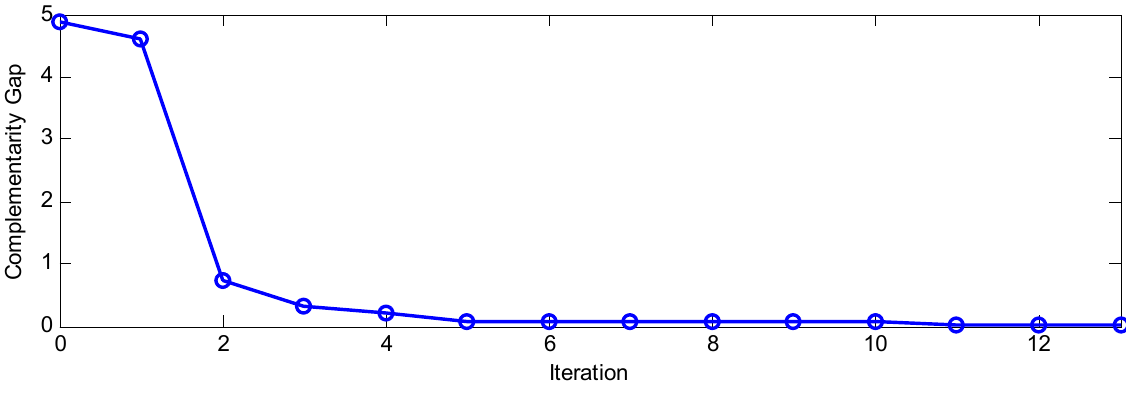
Figure 2. The total generation cost as a function of  .